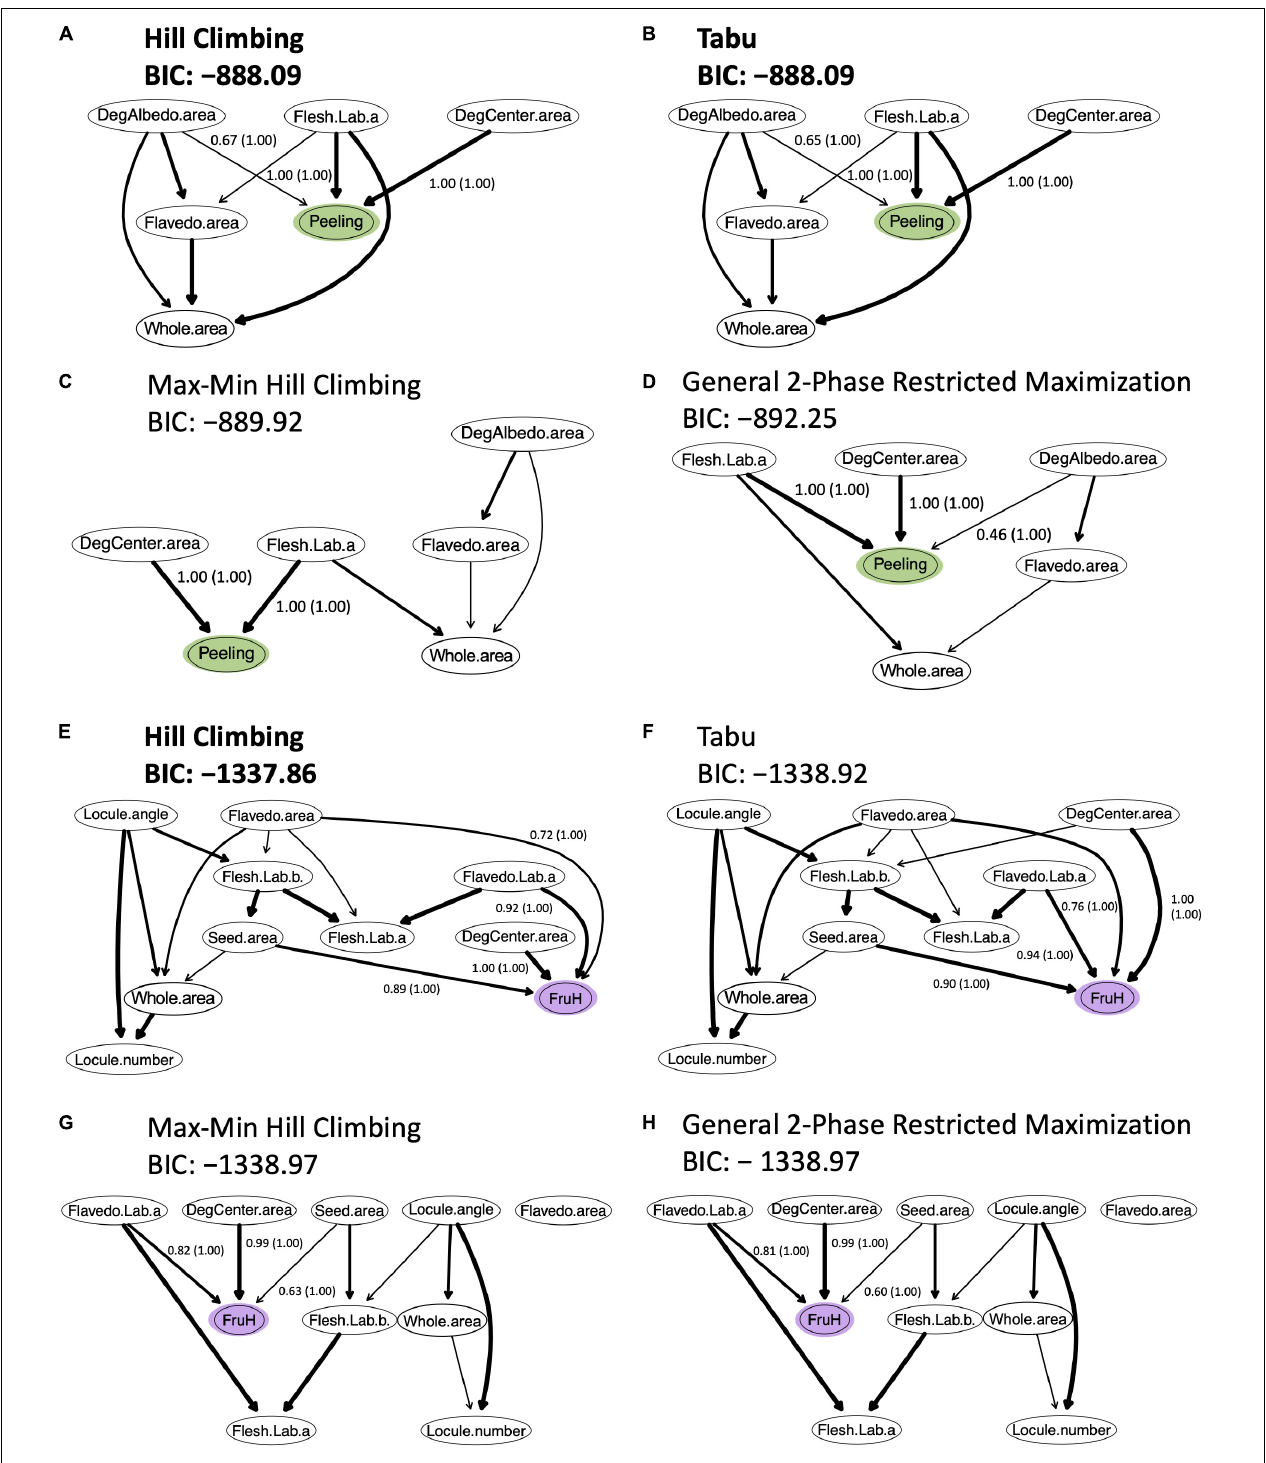
FIGURE 5 | Bayesian networks for causal inference between fruit morphological features and breeder-evaluated fruit quality traits. (A–D) Bayesian networks for the Peeling. (E–H) Bayesian networks for the FruH. For each trait, four algorithms were trialed. Two of these were score-based [Hill Climbing (A,E) and Tabu (B,F) ]; the other two were hybrid algorithms [Max-Min Hill Climbing (C,G) and General 2-phase restricted maximization (D,H) ]. Arc thickness represents arc strength. Labels provide the strength (and in parentheses, confidence regarding direction) of arcs; these are only shown for those arcs connecting features with traits. For each trait, the algorithms with the highest Bayesian information criterion (BIC) score are highlighted in bold. A higher BIC score is better because the BIC score is rescaled by − 2 in the “bnlearn” package.